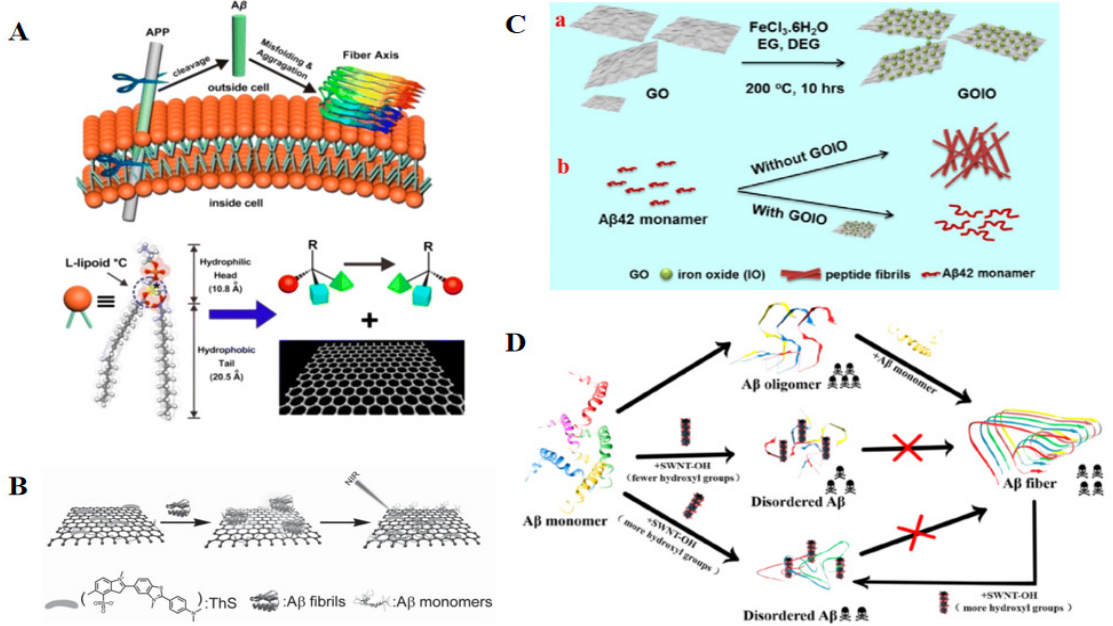
Figure 4. ( A ) Schematic representation of the chiral effect at the protein/graphene interface to understand amyloid formation. Reprinted with permission from reference [73]. Copyright 2014 American Chemical Society. ( B ) Schematic representation of ThS-modified GO with high NIR absorbance used for AD treatment. Reprinted with permission from reference [74]. Copyright 2012 Wiley-VCH. ( C ) Schematic representation of the (a) preparation of GOIO and (b) modulation of A β 1–42 aggregation using GOIO. Reprinted with permission from reference [77]. Copyright 2012 Elsevier. ( D ) Schematic representation of the effect of SWNT-OH on A β aggregation. Reprinted with permission from reference [78]. Copyright 2019 American Chemical